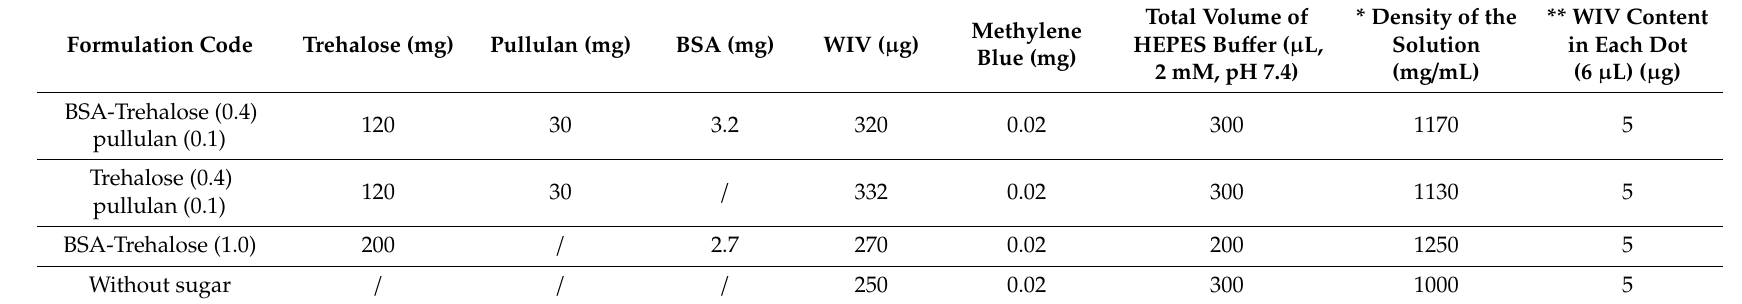
Table 2. Composition of WIV